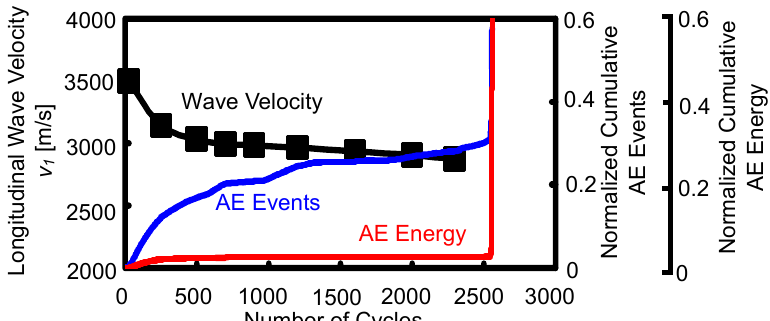
Fig.7. Cumulative AE events and energy and ultrasonic wave velocity during cyclic compression test.